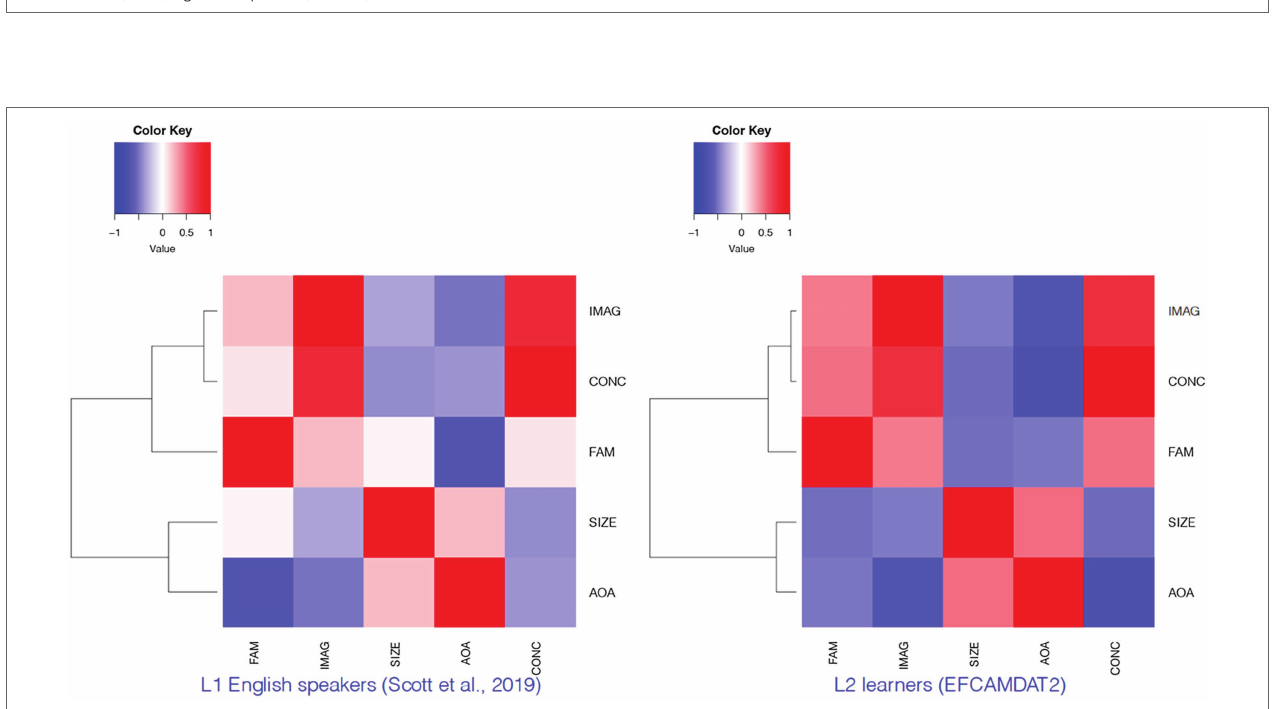
FIGURE 3 | Correlations among the scores of different LPP dimensions for L1 English speakers and L2 English learners. FAM, familiarity; IMAG, imageability; SIZE, semantic size; AoA, age of acquisition; CONC, concreteness.